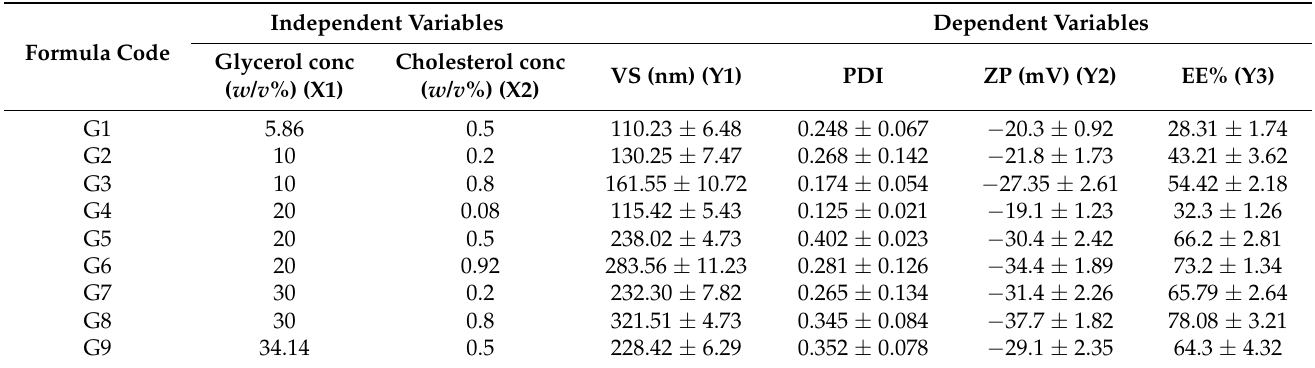
Table 1. Composition of Different Coded formulations with their responses in Central Composite Design for optimization of QTF loaded GLSMs.